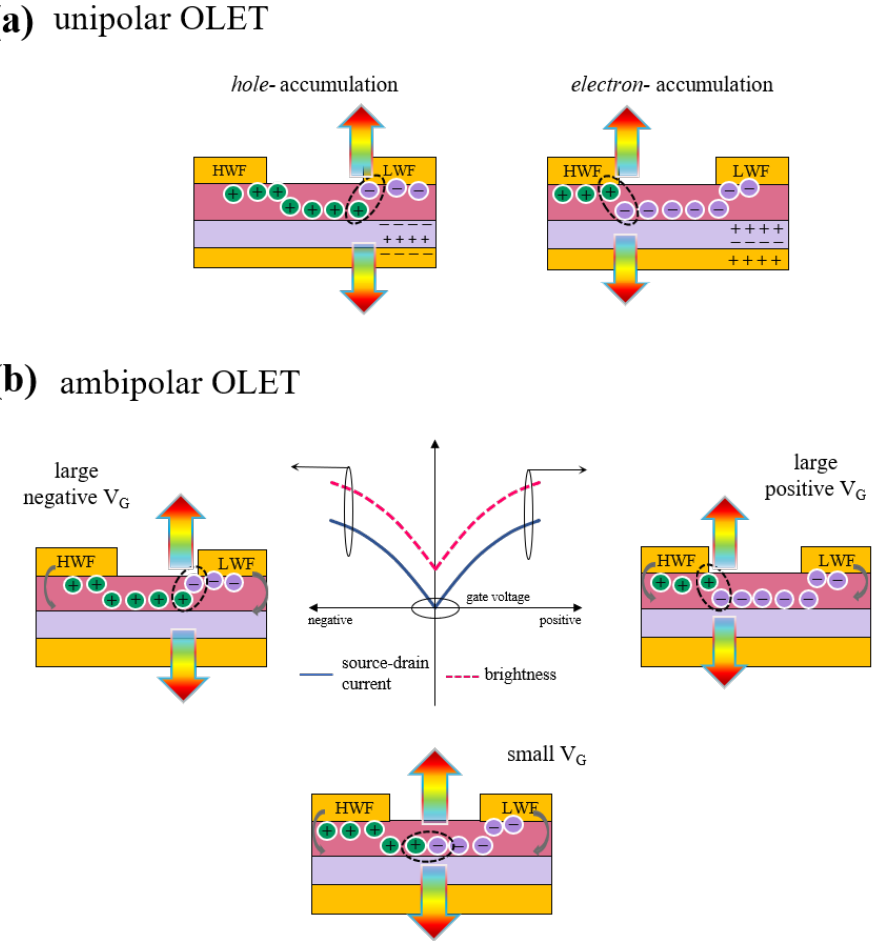
Figure 3. OLET operation: unipolar vs. ambipolar regime. ( a ) Unipolar regime: transport in dominated by holes (electrons), which are injected into the device from the source (drain), but only holes (electrons) accumulate in the channel. ( b ) Ambipolar regime: in the limit of large negative (positive) gate voltage, holes (electrons) accumulate in the channel, and light emission occurs close to the LWF (HWF) electrode (known as e ( h )-injecting electrode). For small gate bias, both charges are injected in the channel, where light emission occurs. Adapted with permission from [22] © (2019) John Wiley and Sons.